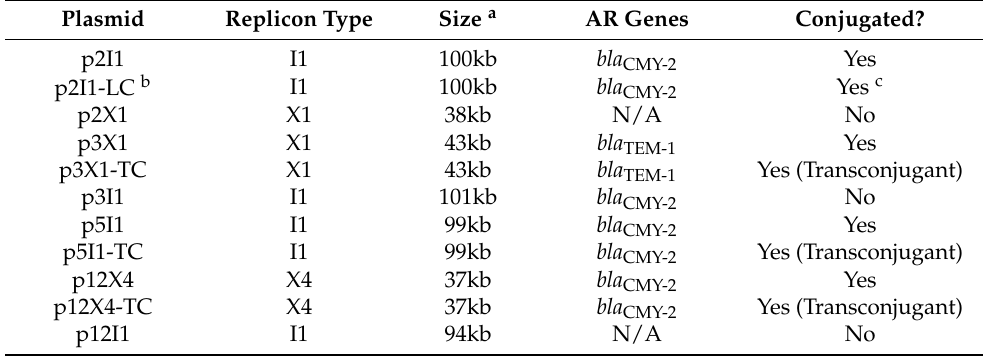
Table 2. Sequenced plasmids information.